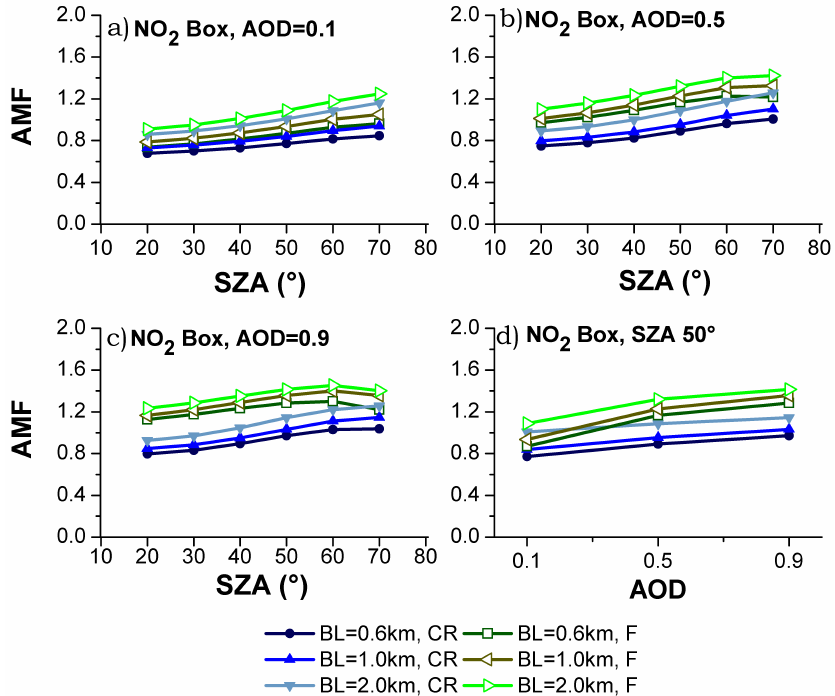
Fig. 6. NO 2 airmass factors for different boundary layer heights. Scenarios A, C and H (well mixed NO 2 and aerosol layers in boundary layer (BL) extending to: 0.6, 1.0 and 2.0km, respectively) were used with the phase functions determined for coarse (CR) and fine (F) particles (optical properties taken from Creteil/Paris AERONET station). AMFs determined at 440nm, with surface albedo = 0.03, ω 0 = 0.93 and different AODs: (a) 0.1, (b) 0.5 and (c) 0.9. AMFs results in panel (d) are presented for SZA = 50 ◦